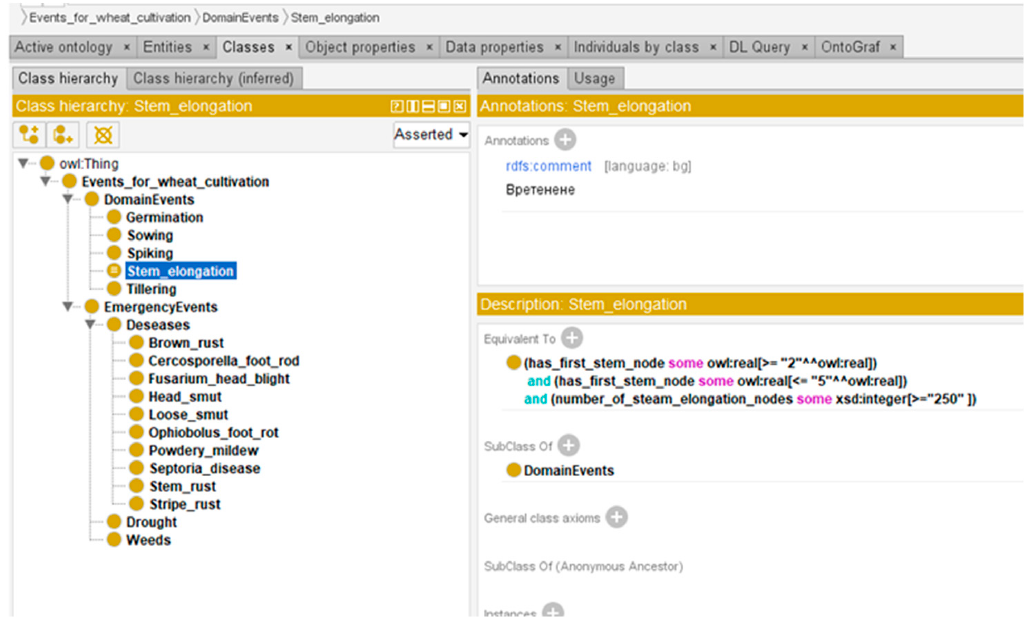
Figure 14. The Equivalent To axiom about the stem_elongation event.